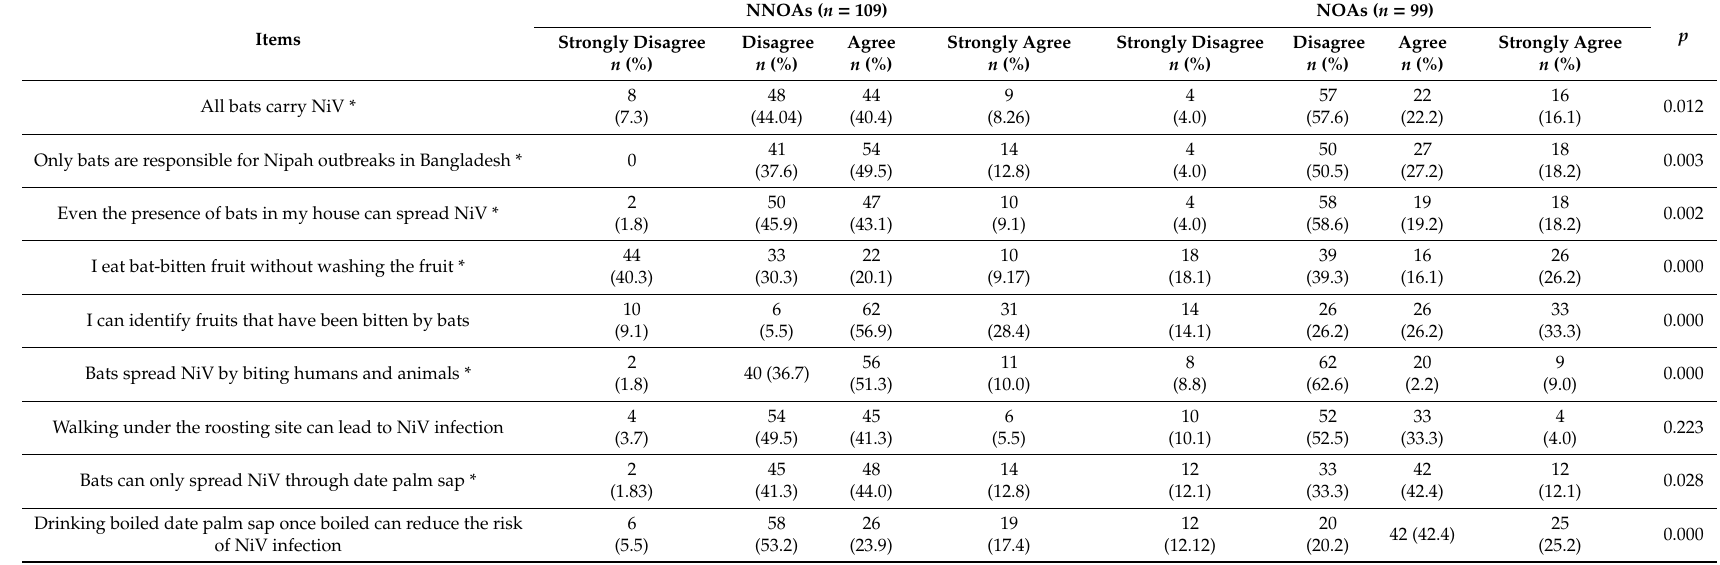
Table 5. Knowledge, attitudes, and perceptions of the spreading of NiV by